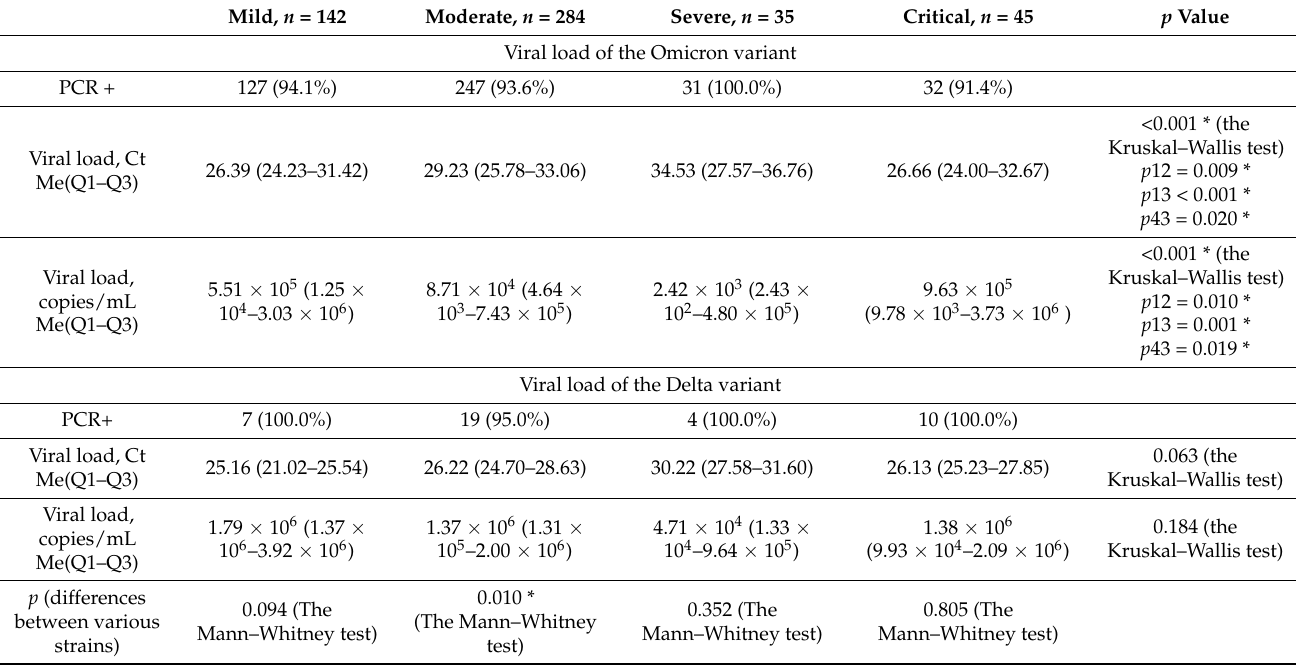
Table 3. Viral load depending on severity ( n =